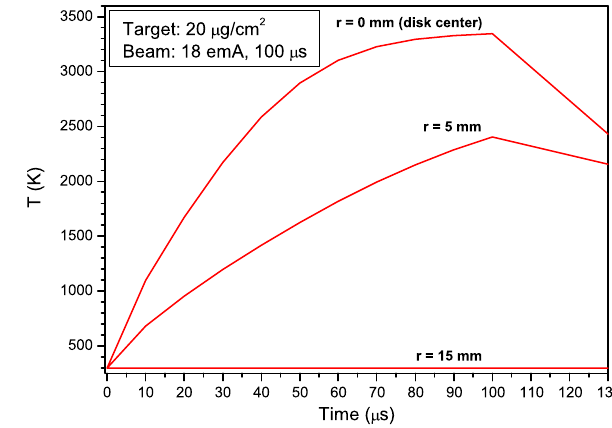
FIG. 9. Same as in Fig. 8, but using an exponential ion charge distribution.